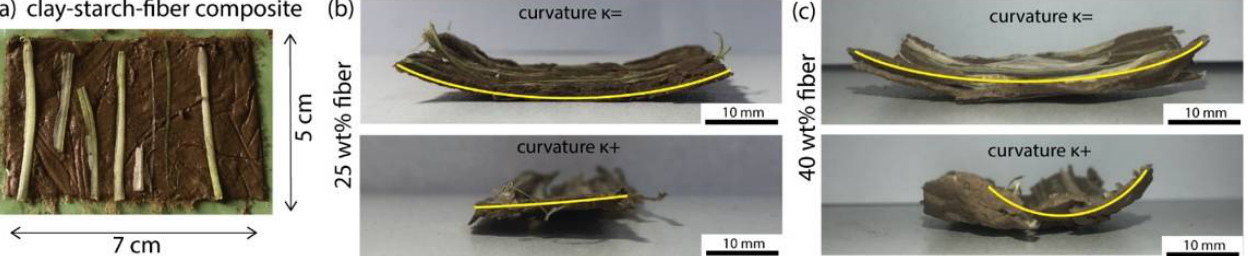
Figure 6. Anisotropic clay–starch–fiber composites. ( a ) Picture of the top view of a composite containing 32 vol% clay and 25.8 vol% starch laid up with parallel celery fibers of various lengths. Optical images of the composite monolayers after drying, highlighting their deformation for 25 wt% fiber content ( b ) and 40 wt% fiber content ( c ). In yellow are highlighted the curvatures of the monolayer samples with κ = the curvature along the fiber direction and κ + the curvature perpendicular to the fiber direction.